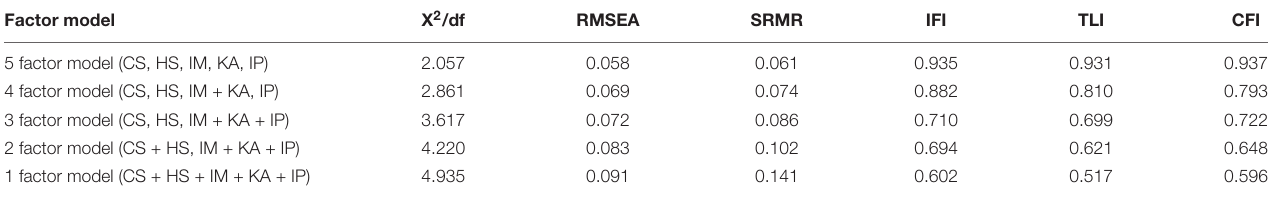
TABLE 3 | Confirmatory factor analysis results.